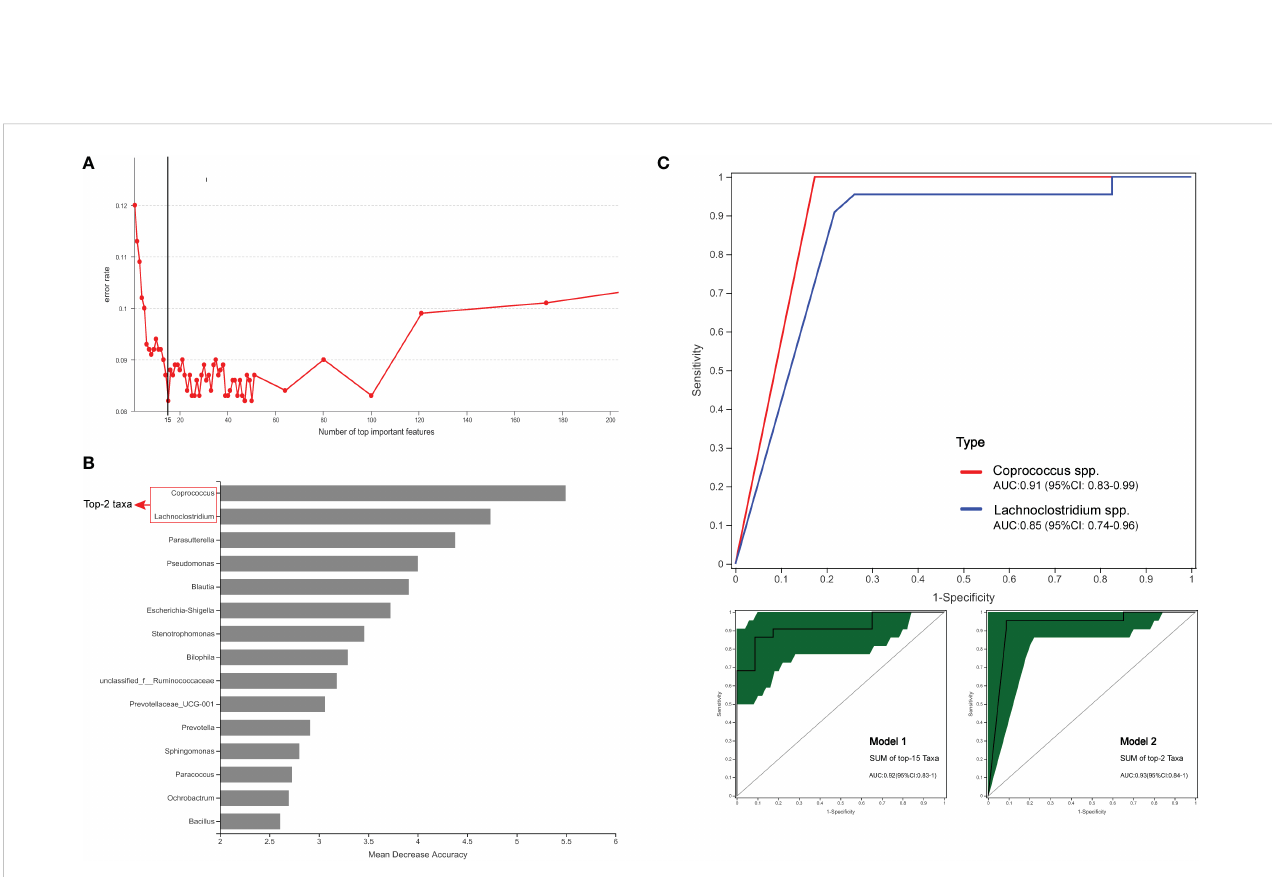
FIGURE 8 Comparison of bacterial (genus) candidate markers for the diagnostic prediction of DM SCRC. (A) The method of 10-fold cross-validation was used to determine the model with the lowest error rate of the ROC curve. (B) At the genus level, the relative abundance of the top15 hits, including Lachnoclostridium and Coprococcus . (C) ROC analysis of taxa relative abundance as predictive of DM status. The above fi gure shows the diagnostic performances of the bacteria (genus) Lachnoclostridium and Coprococcus . The fi gure below shows that Model 1 consists of the top 15 hits (left panel) and Model 2 consists of the top 2 hits (right panel). Different colors represent different groups of species.